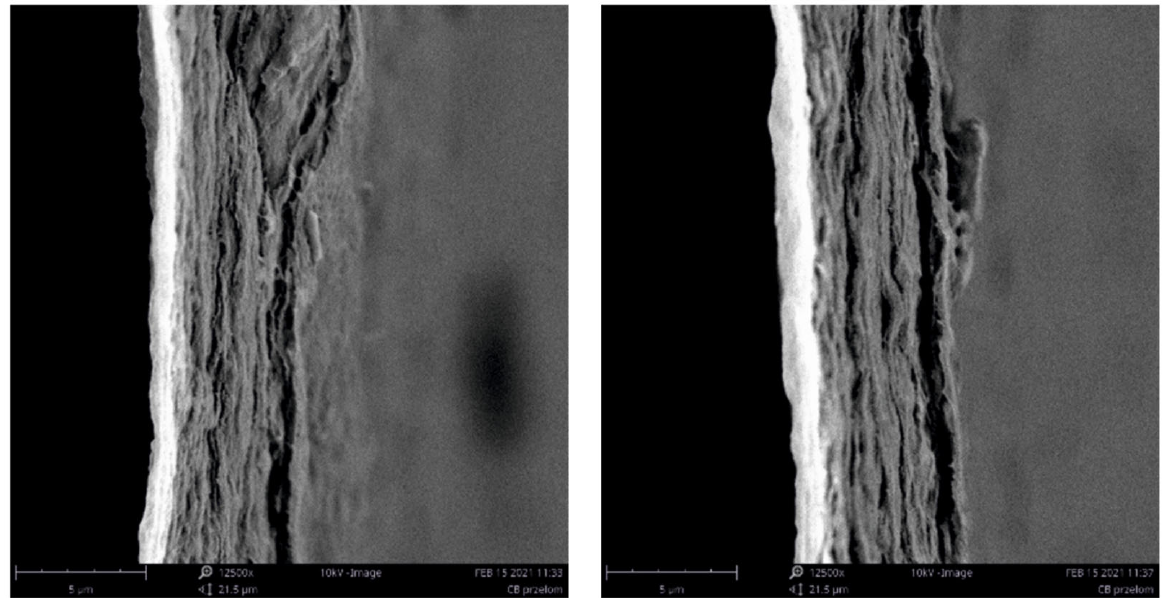
Figure 7. SEM photos of the BC/0 membrane